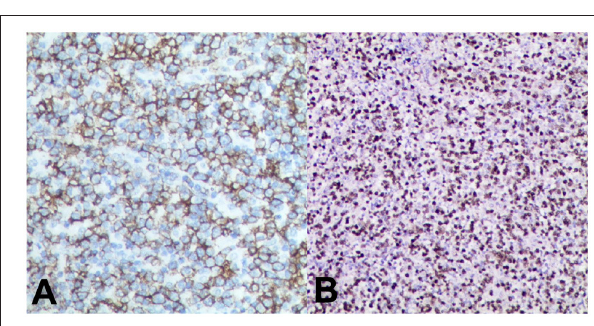
FIGURE 2 | Immunochemistry of lymph nodes derived from the neck area. (A) Atypical cells are positive for CD56. (B) Cells are also positive for EBV with in situ